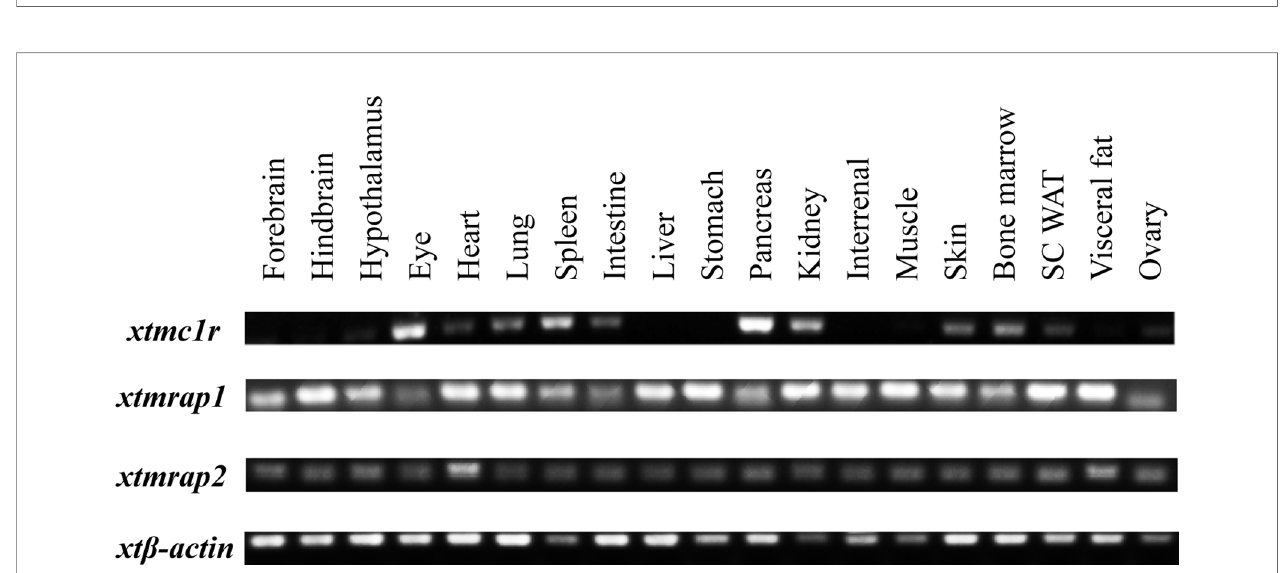
FIGURE 3 | Expressional analysis of mc1r transcript in multiple tissues of Xenopus tropicalis . Expression pro fi les of mc1r , mrap2 , and mrap2 transcript in 19 tissues from an adult female Xenopus tropicalis . Housekeeping gene b -actin was used as an internal